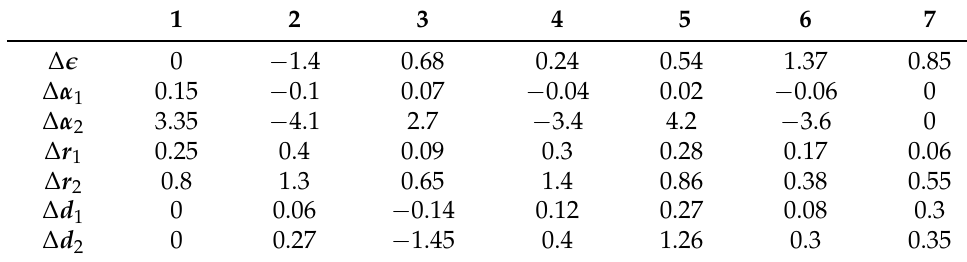
Table 2. Deviations of DH